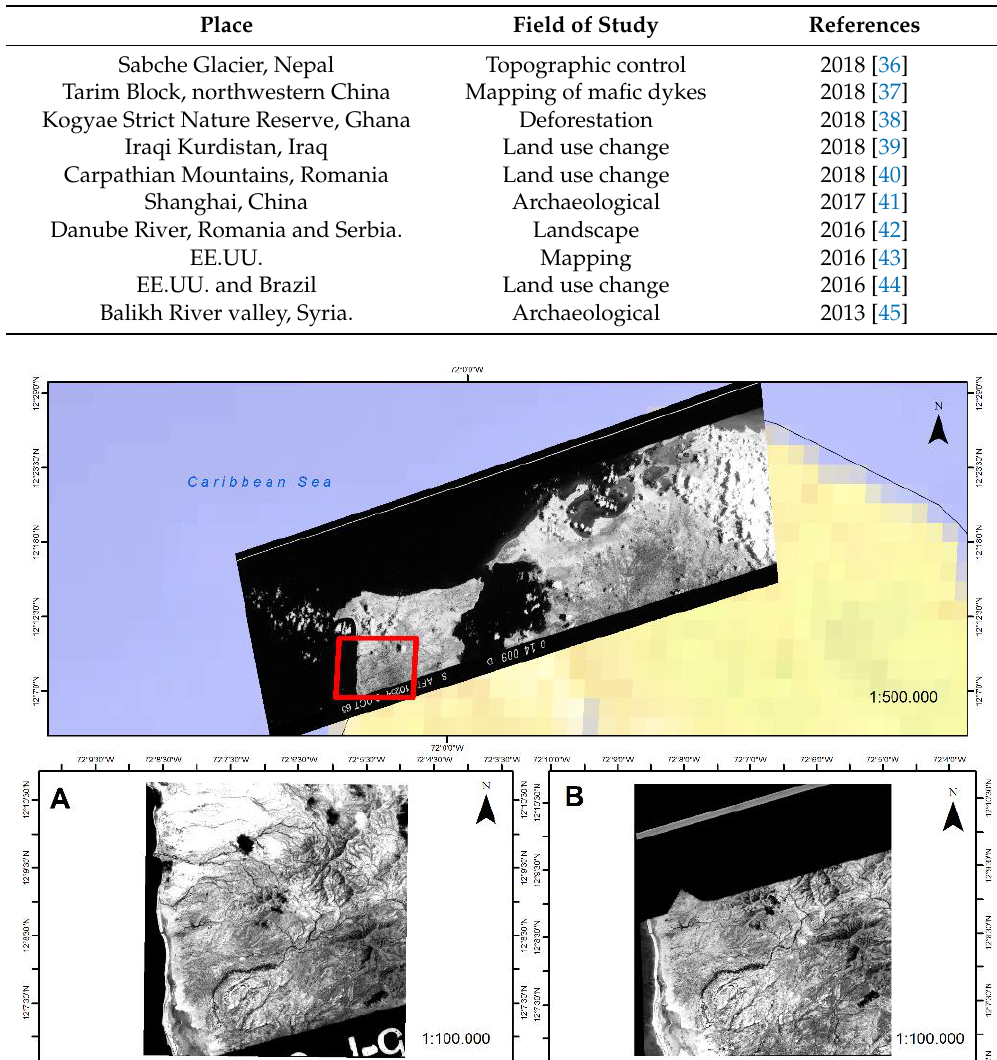
Table 2. Studies that use Corona images.